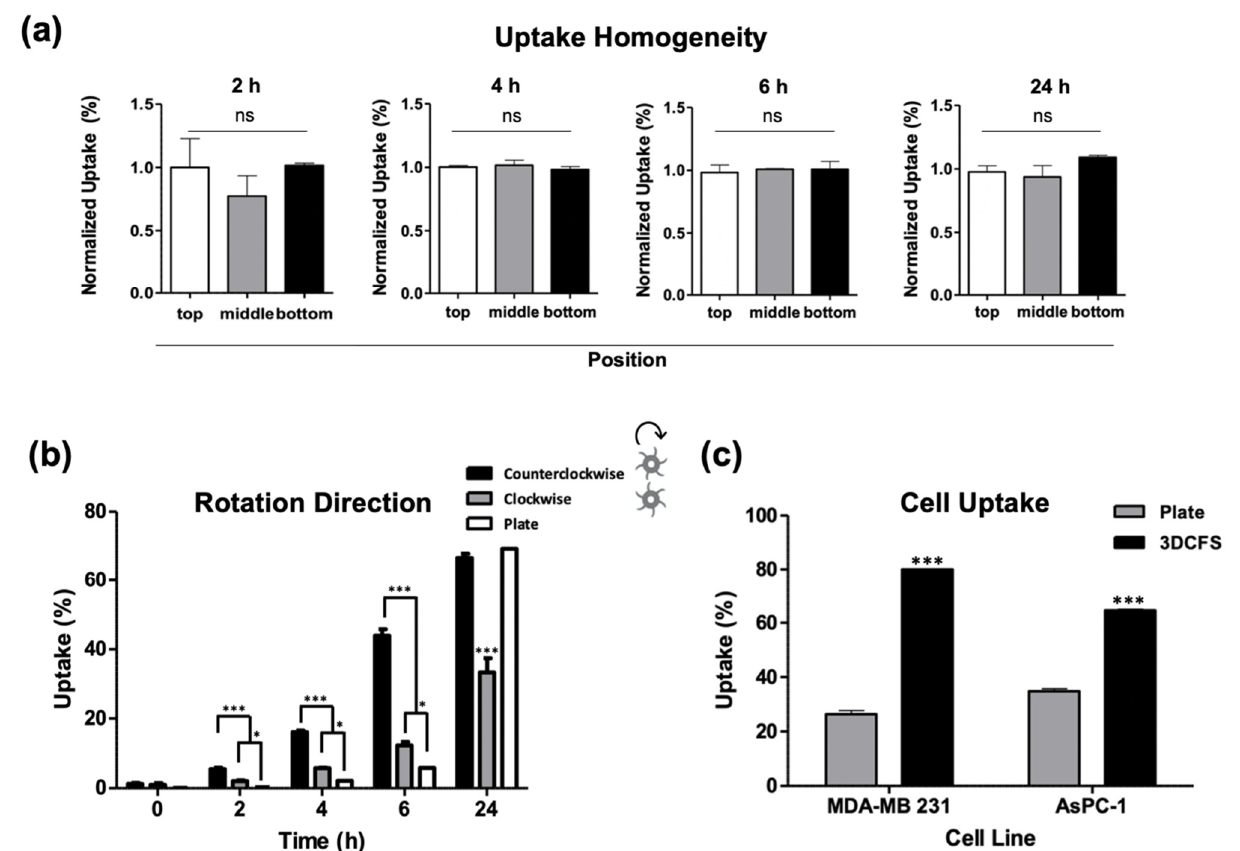
Figure 4. Validation of the 3DCFS performance. ( a ) Cells were sampled from the 3DCFS’s bottom, middle and top levels after 2, 4, 6 and 24 h of incubation to measure the homogeneity of their particle uptake levels. For each of the time points, there was no significant difference between the samples. ( b ) Uptake levels were compared between rotation directions in floating conditions and with the uptake level in adherent conditions. ( c ) Uptake capability of MDA-MB 231 and AsPC-1 cells was also evaluated both when seeded on a plate and in the 3DCFS. Both cells showed significant increase in the capability of the cells to uptake the particles after 6 h of incubation in the 3DCFS compared to the plate. p -value: *** ≤ 0.001, * ≤ 0.05, ns > 0.05.